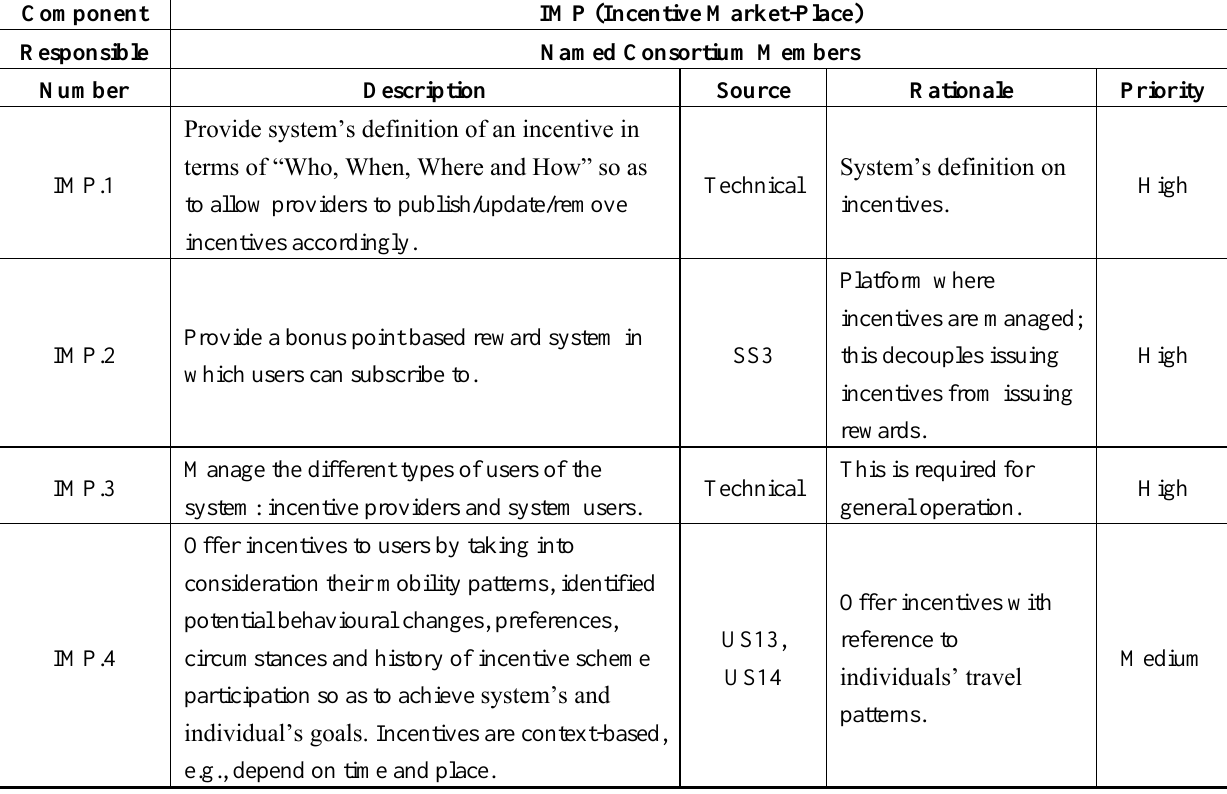
Table 2. Exemplar IMP (Incentive Market-Place) system component requirements where SS represents the transport authority